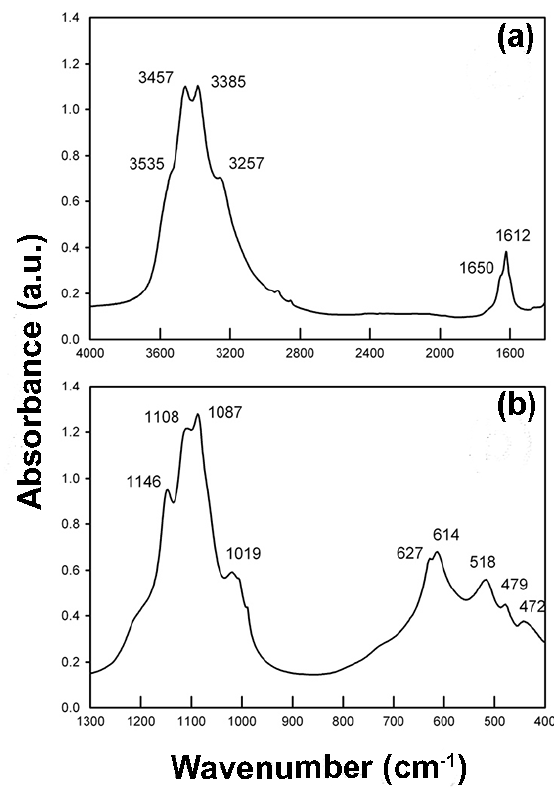
Figure 4. Room temperature FTIR spectra for the studied melanterite, ( a ) in the H 2 O stretching and bending region and ( b ) at the low-frequency mode region.